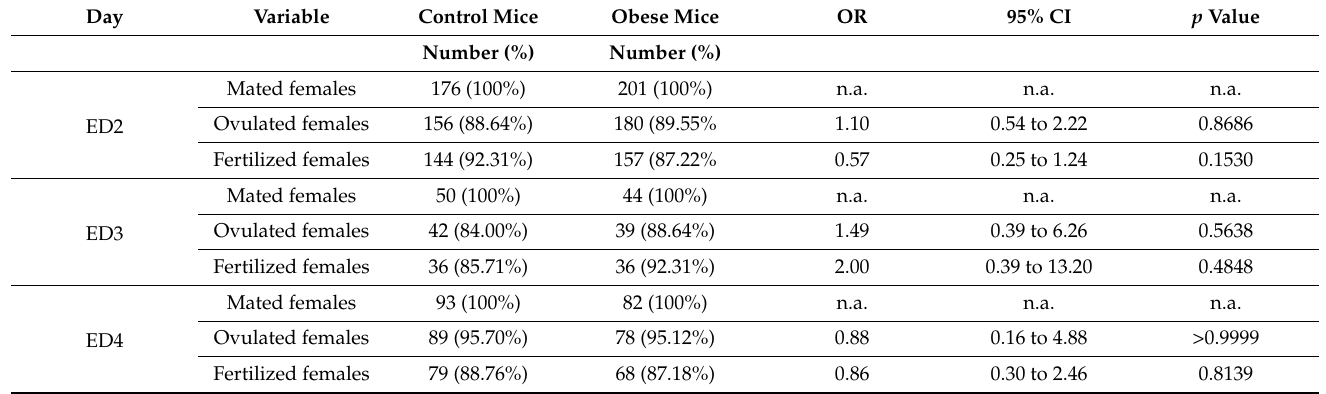
Table 1. Effect of female overweight status on ovulation and fertilization rate.